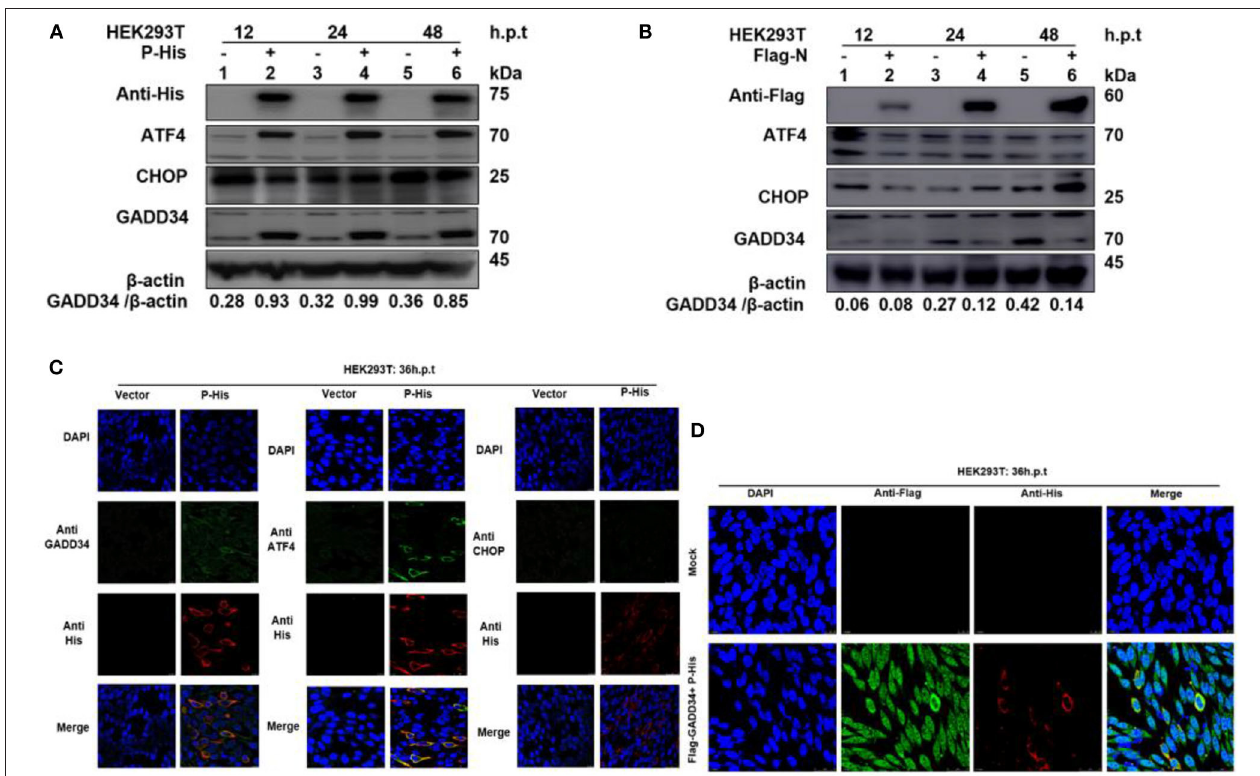
FIGURE 6 | PPRV P protein induces host cellular GADD34. (A,B) HEK 293T cells were transfected with either His-tagged P protein expressing plasmid (in A ) or Flag-tagged N protein expressing plasmid (in B ) or mock-transfected with an empty vector at indicated times. The effect of PPRV P or N proteins on ATF4, CHOP, and GADD34 protein expression was analyzed by Western blot and β -actin was used as an internal loading protein. (C) HEK 293T cells were transfected with His-tagged P protein expressing plasmid or empty vector for 36h. Cells were fixed and double-stained with Rabbit anti-GADD34 (10449-1-AP) 1:100, Rabbit anti ATF4 (10835-1-AP) 1:100, and Rabbit anti-CHOP (D46F1) 1:50, and His-tagged P protein was stained with Mouse anti-His-tag (66005-1-Ig) 1:200 as primary antibodies overnight. Goat anti-rabbit IgG (H&L) Alexa Fluor 488 (ab150077) Green 1:500 and Goat anti-mouse IgG H&L (Alexa Fluor 647) (ab150115) Red 1:1000 were used as secondary antibodies. DAPI was used to stain the cell nuclei (blue). (D) Colocalization of PPRV P protein with GADD34. HEK 293T cells were co-transfected with His-tagged P protein expressing plasmid and Flag-tagged GADD34 for 36h followed by double staining with Rabbit anti-Flag (ab1162) 1:200 and Mouse anti-His-tag (66005-1-Ig) 1:200 as primary antibodies overnight. Goat anti-rabbit IgG (H&L) Alexa Fluor 488 (ab150077) Green 1:500 and goat anti-mouse IgG H&L (Alexa Fluor 647) (ab150115) Red 1:1000 were used as secondary antibodies. DAPI was used to stain the cell nuclei